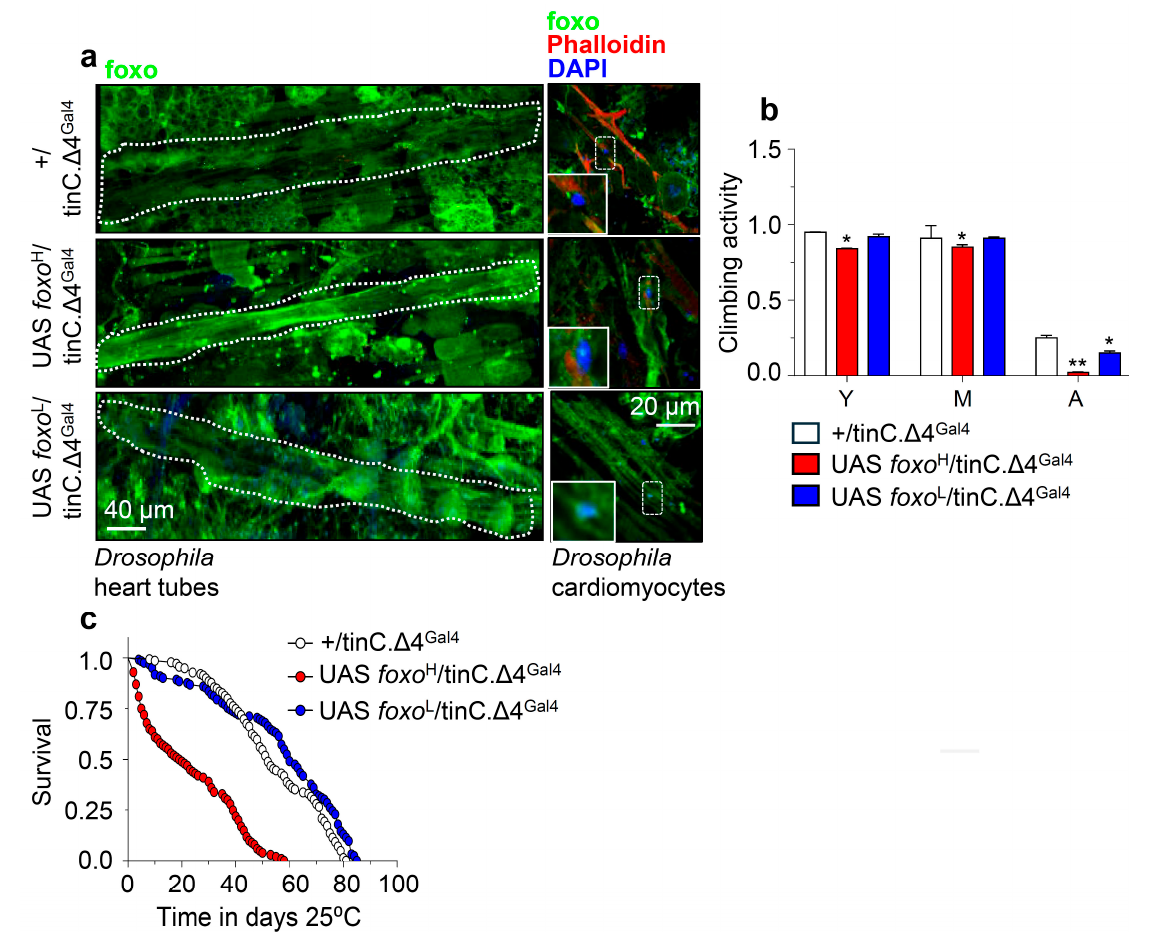
Figure 5. Cardiomyocytes-targeted foxo OE induces heart-tissue remodeling and impacts flies’ physiology. ( a ) Representative CLSM images of intact young Drosophila heart tubes and of cardiomyocytes following foxo H or foxo L heart-specific (tinC. ∆ 4 Gal4 ) OE; samples were stained with an anti-FOXO antibody and counterstained with DAPI to visualize nuclei. ( b ) Locomotion (climbing activity) of young (Y), middle-aged (M), and aged (A) flies of the indicated genotypes and ( c ) longevity of shown transgenic flies after heart-targeted foxo OE vs. controls. Statistics of longevity assays are reported in Table S1. Bars, ± SD; n ≥ 3, ≥ 10 flies were analyzed per experimental repeat. In ( b ) statistical significance was measured with the unpaired t -test, * p < 0.05, ** p <